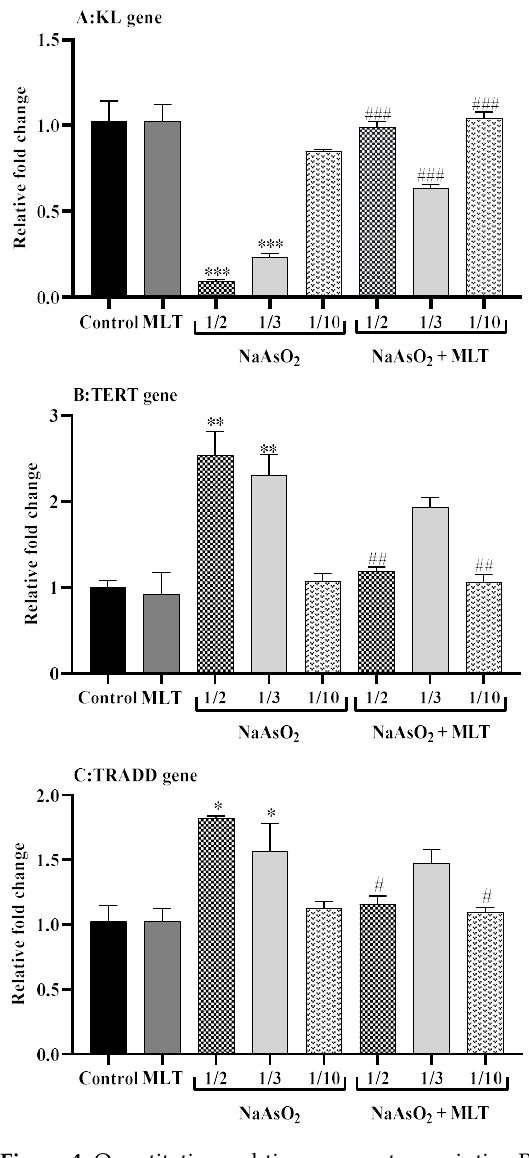
Figure 4. Quantitative real-time reverse transcription PCR for gene expression ( A ) Telomerase reverse transcriptase (TERT) gene expression; ( B ) Type 1 associated death domain tumor necrosis factor receptor (TRADD) gene expression; ( C ) Klotho related (KL) gene expression. Abbreviations: MLT; melatonin, NaAsO 2 ; sodium arsenite; Results are expressed as mean ± SEM. Samples were analyzed in triplicate. *** p < 0.0001; ** p < 0.001; * p < 0.05 (Vs. control or melatonin) ### p < 0.0001; ## p < 0.001; # p < 0.05 (Vs. 1 LD50 NaAsO 2 2